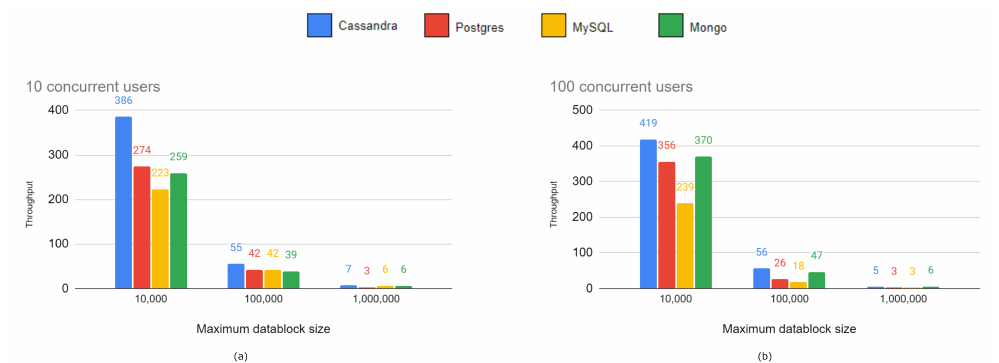
Figure 9. Comparison of the throughput of the different implementations with ( a ) 10 concurrent users and ( b ) 100 concurrent